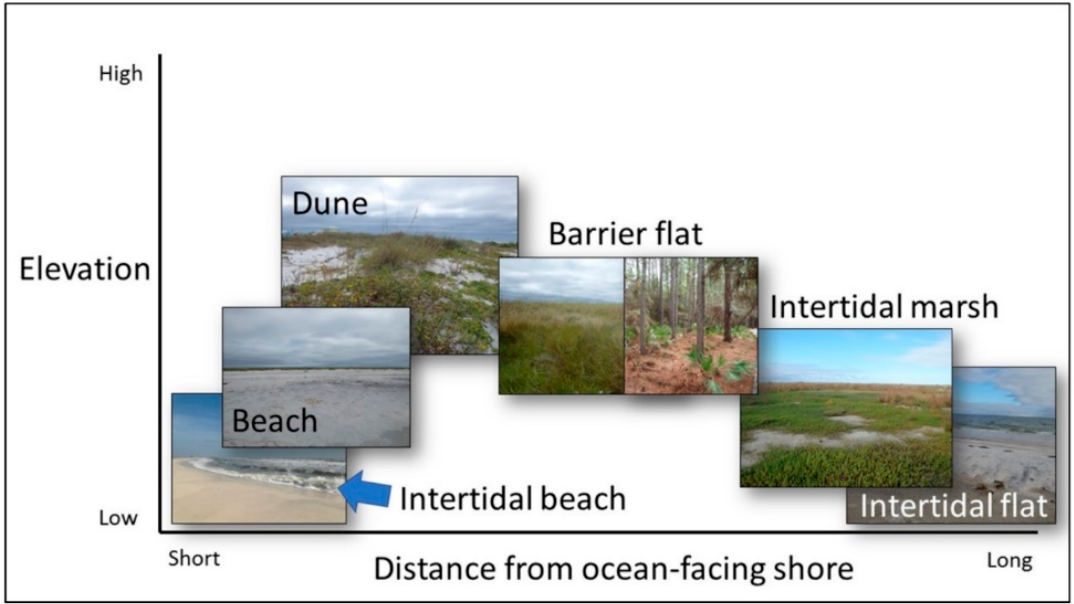
Figure 1. Hypothesized relationship between elevation and distance from ocean-facing shoreline for general barrier island habitats based on literature [19,35] .